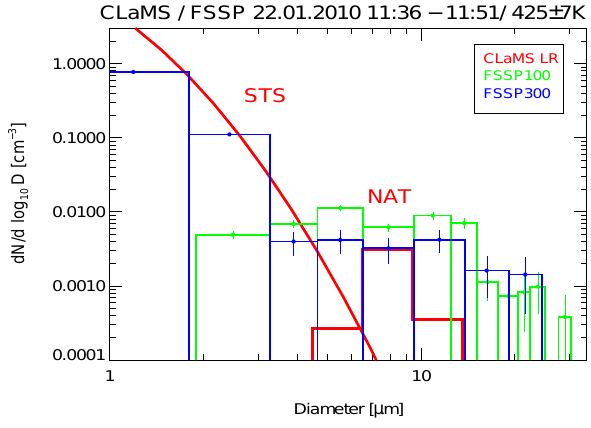
Fig. 5. Particle size distribution from FSSP observations on 22 Jan- uary 2010. Shown are both FSSP-100 and FSSP-300 data for the flight segment between 11:36 and 11:51UTC which had one of the largest particle concentrations during this campaign. The cor- responding CLaMS particle size distribution (red) has two compo- nents, the liquid STS peak and the NAT particle combined from all CLaMS NAT particles within 100km of the flight path